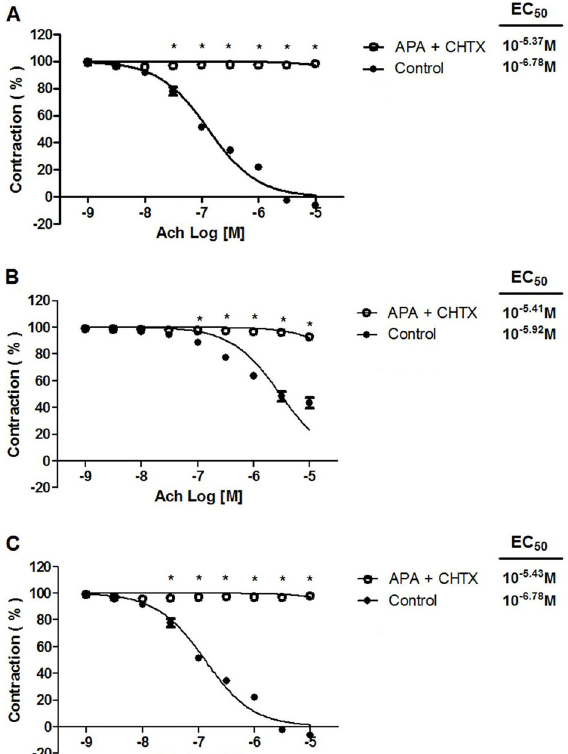
Figure 6. Effect of 10 – 7 M apamin plus 10 – 7 M charybdotoxin (APA + CHTX) on acetylcholine (Ach) relaxation of endothelium- intact rat aortic rings precontracted with 10 – 6 M phenylephrine. The rings were extracted from rats fed: A ) the standard diet; B ) the cafeteria-style diet (CAF) diet; and C ) the CAF-diet plus rosuvastatin treatment. Data are reported as means ± SE of n = 6 observations. *P o 0.001 vs control (two-way ANOVA).